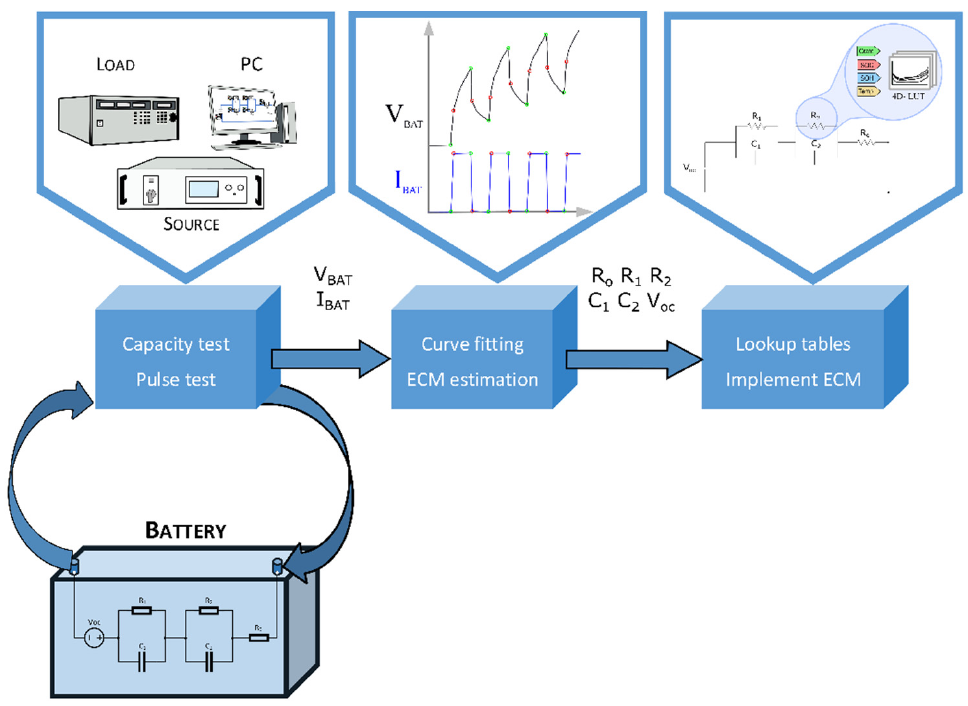
Figure 5. Procedure followed for parameter extraction and estimation.